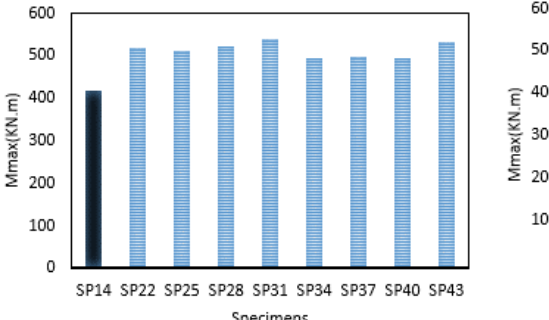
Figure 12. M max of all connections.